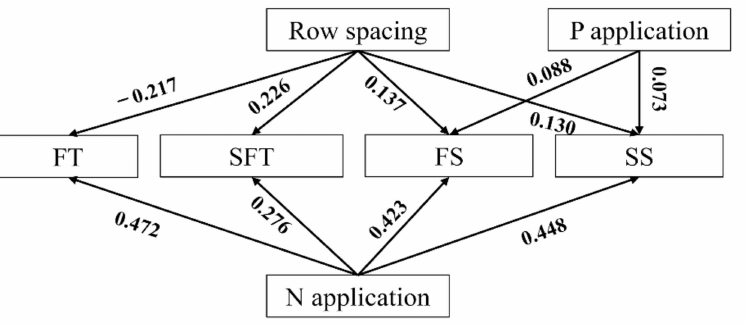
Figure 2. Pathway analysis of row spacing and N/P application on fertile tillers m − 2 (FTs), spikelets per fertile tiller (SFT), florets per spikelet (FS), and seeds per spikelet (SS) in smooth bromegrass. The numbers on the lines indicate pathway